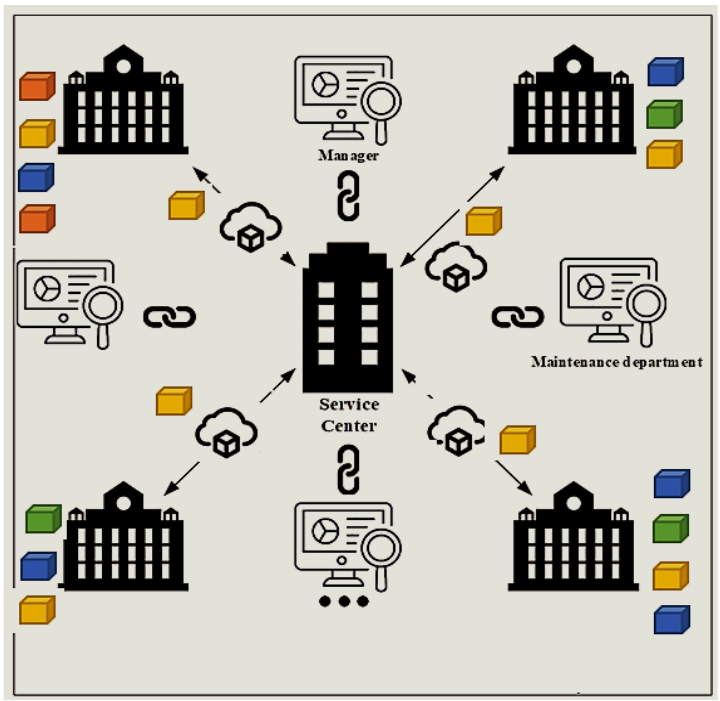
Figure 7. The chains between the service center and other departments.